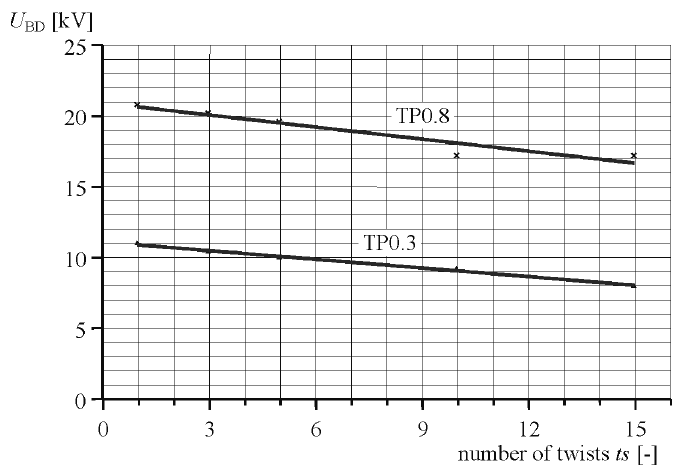
Figure 6. The dependence of breakdown voltage U BD on the number of twists t s in samples TP 0.3 and TP 0.8 at AC test voltage.